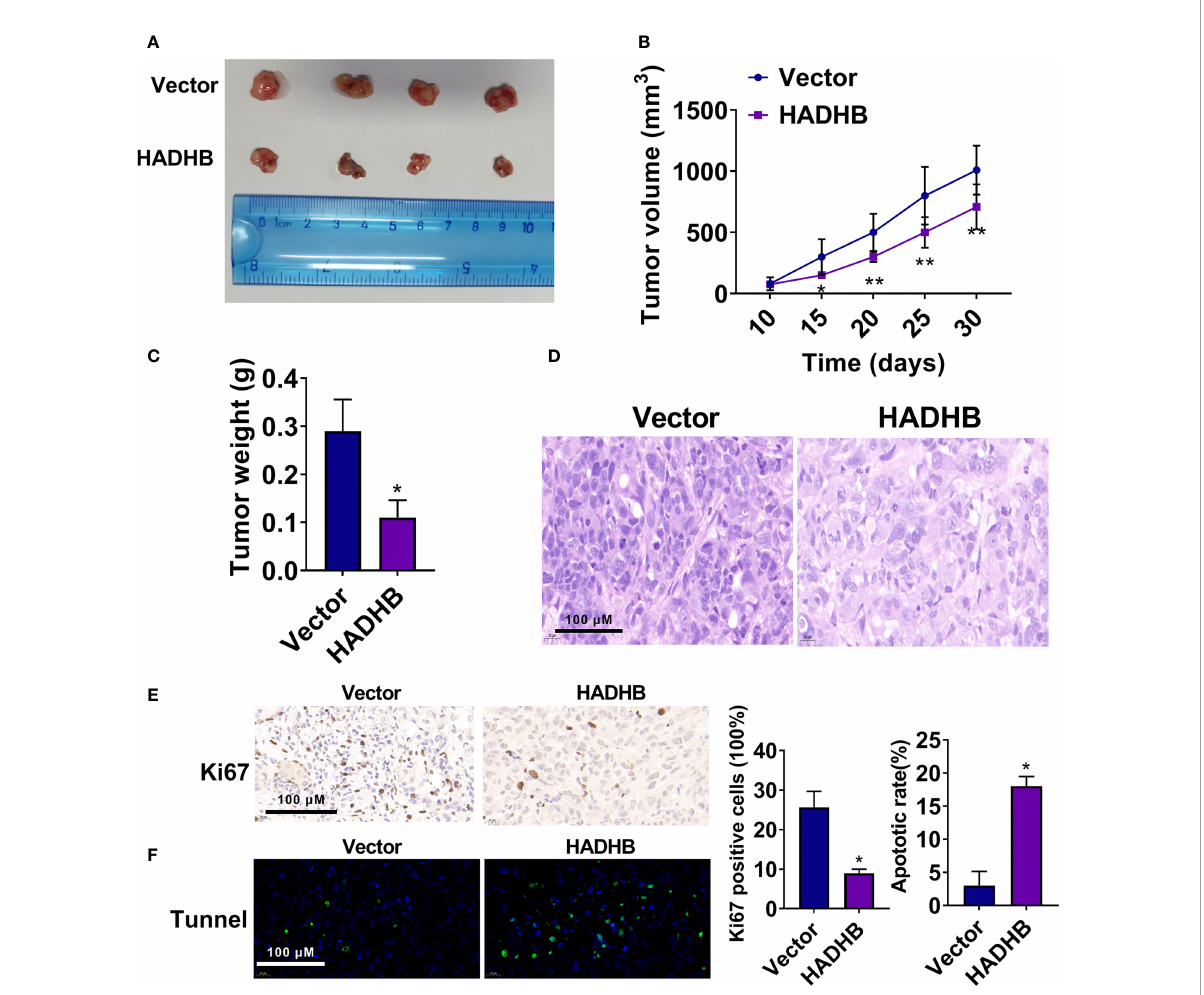
FIGURE 4 HADHB upregulation impeded tumour growth in xenograft BALB/c nude mice (A) . Images of the tumours (4 in each group). (B) . Tumour volume was calculated using the formula: tumour volume (V, mm 3 )=0.5×length×width×width. (C) . Tumour weight was determined. (D) . Histopathological analysis of the collected tumour tissues was performed using H&E staining. (E, F) . Tumour cell proliferation and apoptosis were assessed via immunohistochemistry with the Ki67 antibody and TUNEL assay, respectively. * P < 0.05, ** P <